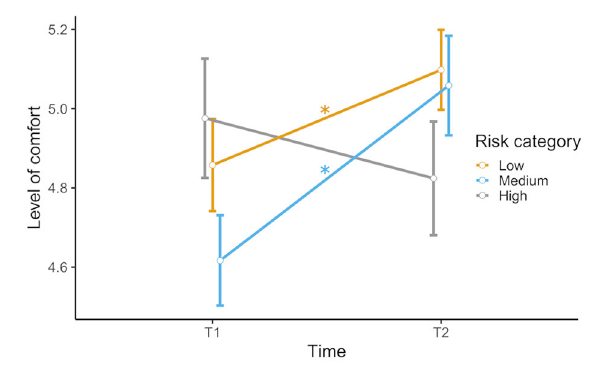
FIGURE 3 | Rated level of comfort in low-, medium-, and high-risk scenarios before (T1) and during (T2) the COVID-19 pandemic. Error bars indicate standard error (S.E.). Significant comparisons of T1 and T2 are indicated by asterisks.